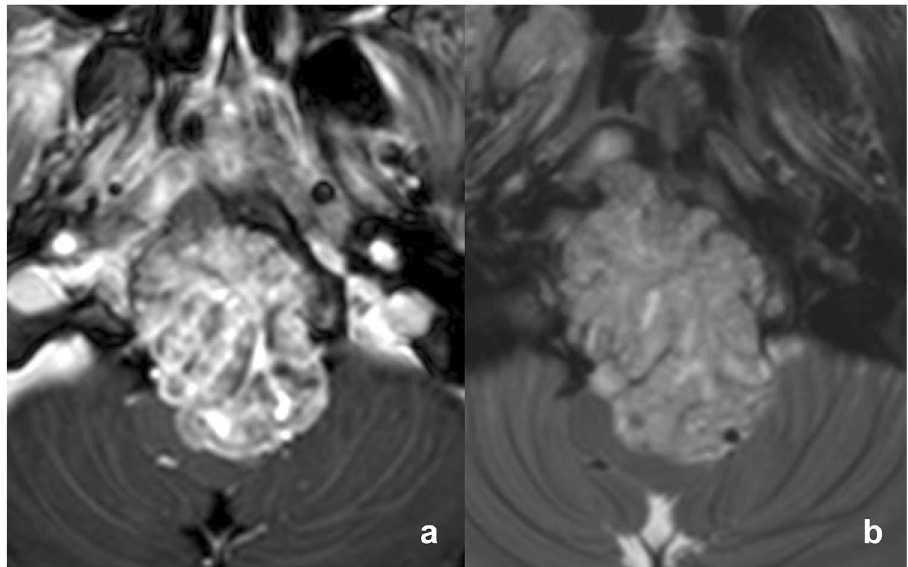
Figure 1. Magnetic resonance imaging of stroma-rich chordoma. ( a ) Contrast-enhanced T1-weighted and ( b ) T2-weighted imaging show an avidly enhancing expansile mass extending from the clivus with T2 intermediate signal intensity.